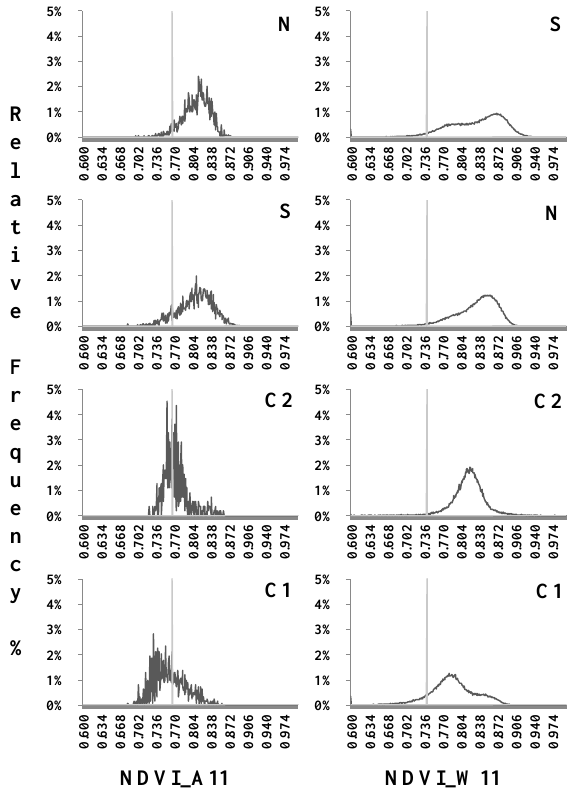
Figure 4. Relative frequency histograms of NDVI values. Based